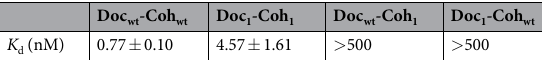
Table 3. Kd values of cohesin-dockerin